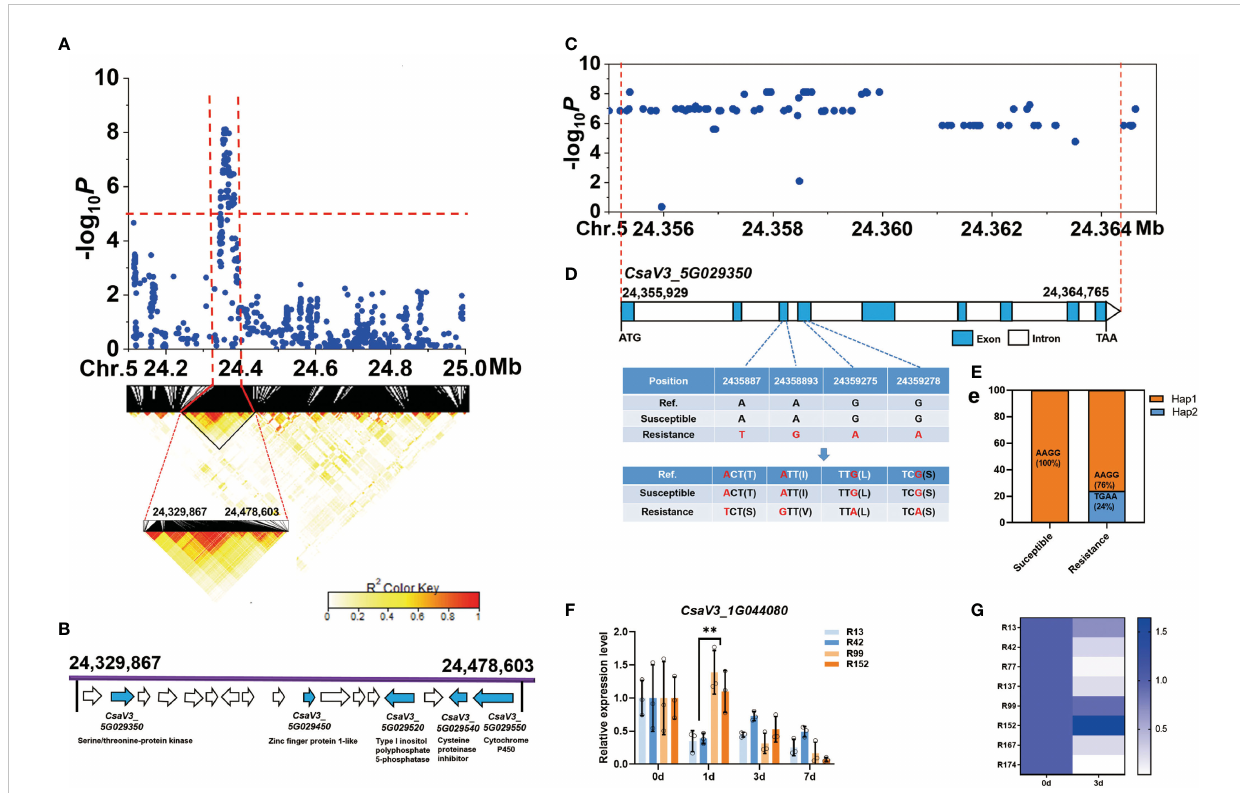
FIGURE 7 Identi fi cation of cucumber low-temperature germination trait-associated gene CsaV3_5G029350 . (A) Local Manhattan plot (top) and LD heatmap (bottom) surrounding the peak on chromosome 5. The dashed line indicates the signi fi cance threshold ( P < 10 − 6 ). Dashed lines indicate the candidate region (~ 148.7 kb) for the peak. (B) Seventeen functionally annotated genes were predicted in the gLTG5.2 candidate region. The arrows represent the direction of the genes. The genes shown as blue arrows are related to abiotic stress and their annotation is indicated. (C) The corresponding DNA polymorphisms of CsaV3_5G029350 with signi fi cant associations. (D) Gene structure of CsaV3_5G029350 . Blue and white rectangles indicate exons and introns, respectively. (E) Bar chart showing the proportion of haplotypes - orange represents the proportion of accessions that are Hap1 (TGAA) while blue represents the proportion that are Hap2 (AAGG) among the susceptible and resistant lines, (F) The relative expression level of CsaV3_5G029350 in low-temperature sensitive lines ( ‘ R13 ’ , ‘ R42 ’ ) and low-temperature resistant materials ( ‘ R99 ’ , ‘ R152 ’ ) after low temperature treatment (0, 1, 3 and 7 d), tested through qRT – PCR. Actin was used an internal control. Data are represented as average values with SD of three independent biological replicates. (G) The heatmap indicates relative expression level of CsaV3_4G013480 in LT-sensitive lines ( ‘ R13 ’ , ‘ R42 ’ , ‘ R77 ’ , ‘ R137 ’ ) and LT-resistant lines ( ‘ R99 ’ , ‘ R152 ’ , ‘ R167 ’ , ‘ R174 ’ ) after low temperature treatment (0 and 3 d), tested through qRT – PCR. Actin was used an internal control. Data are represented as the average values with the SD of three independent biological replicates. **Signi fi cant difference ( P <0.01